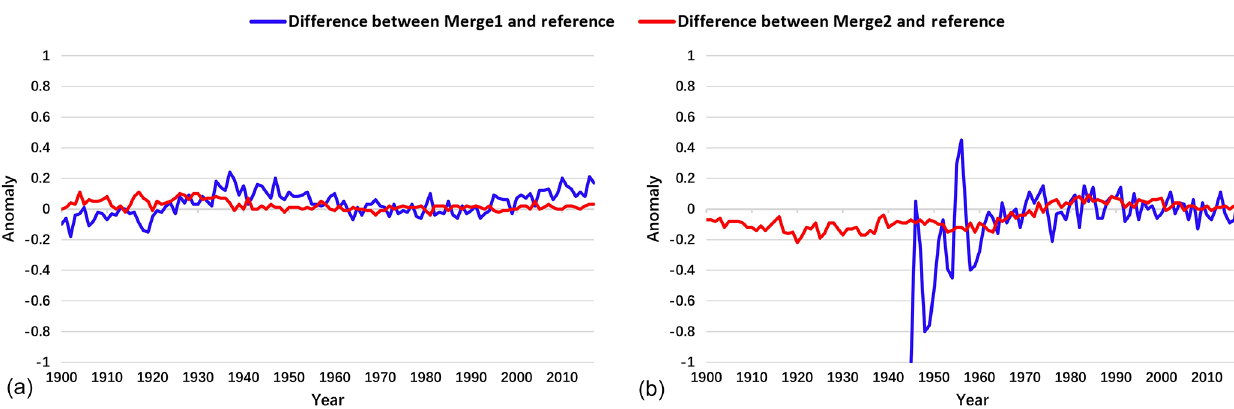
Figure 5. Differences between the merged series and the reference series during 1900–2017 in (a) 90–60 ◦ N and (b) 60–90 ◦ S. The blue line shows the difference between Merge1 and the reference series, and the red line indicates the difference between Merge2 and the reference